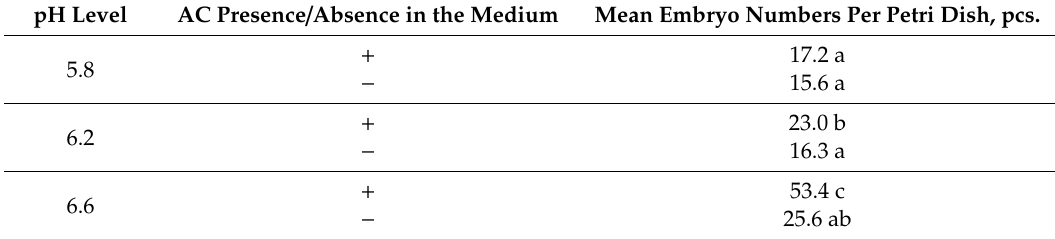
Table 2. Influence of acidity of the medium and AC presence on the development of embryo from microspores of the Roots variety.